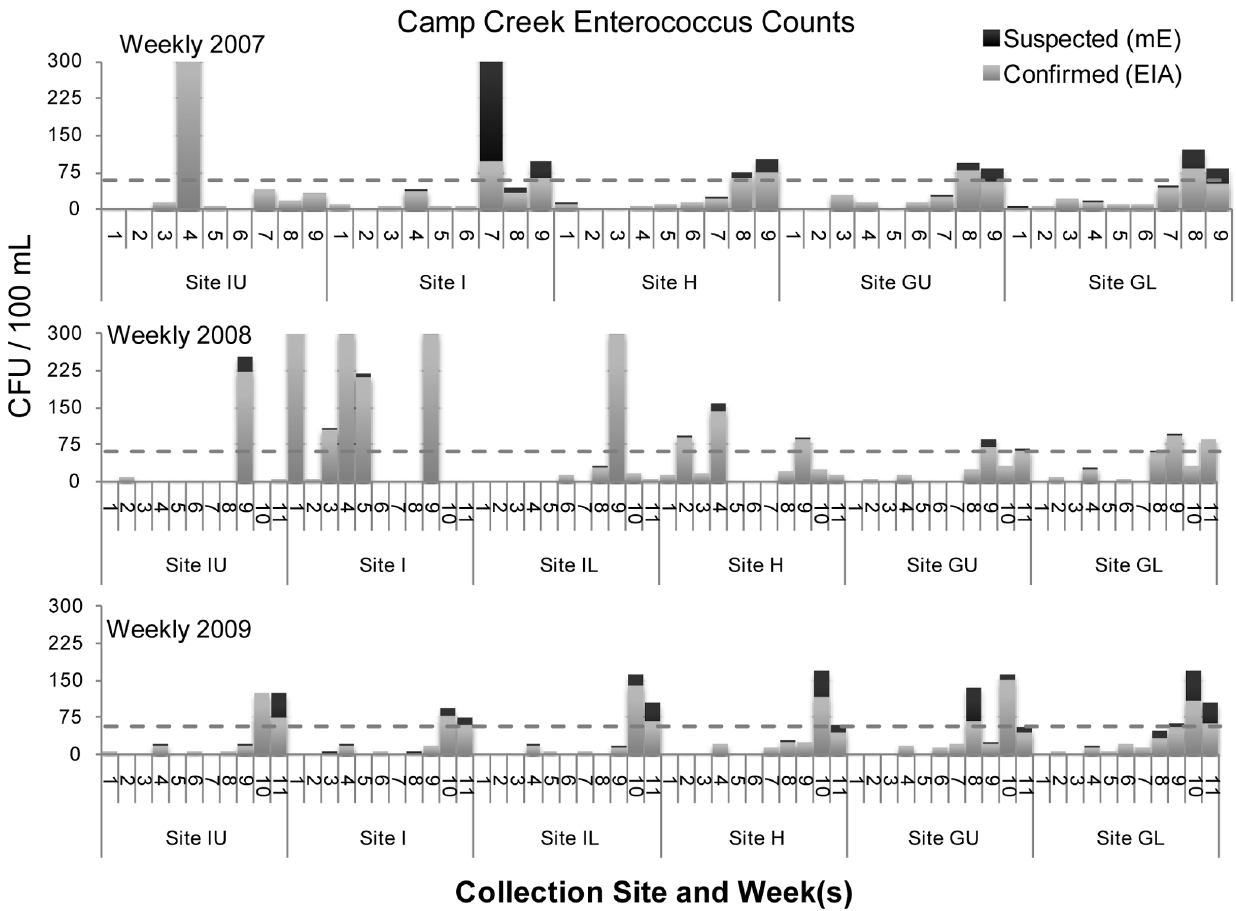
Figure 8. Camp Creek Enterococcus counts.